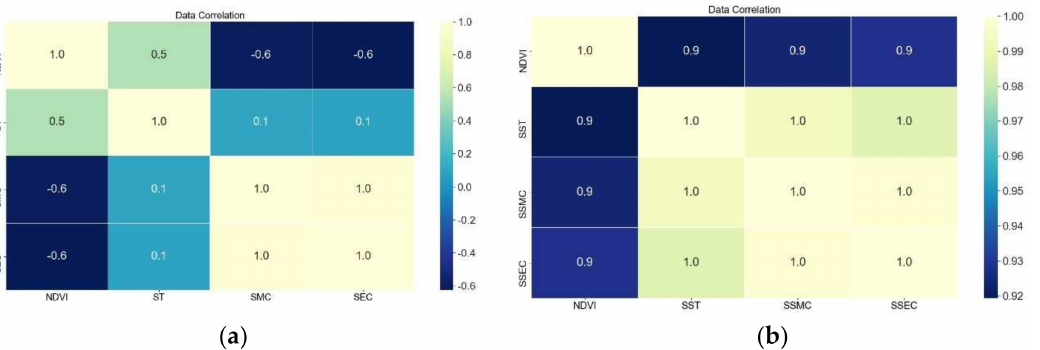
Figure 3. Correlation of soil information data and NDVI. ( a ) soil information data, ( b ) soil information data